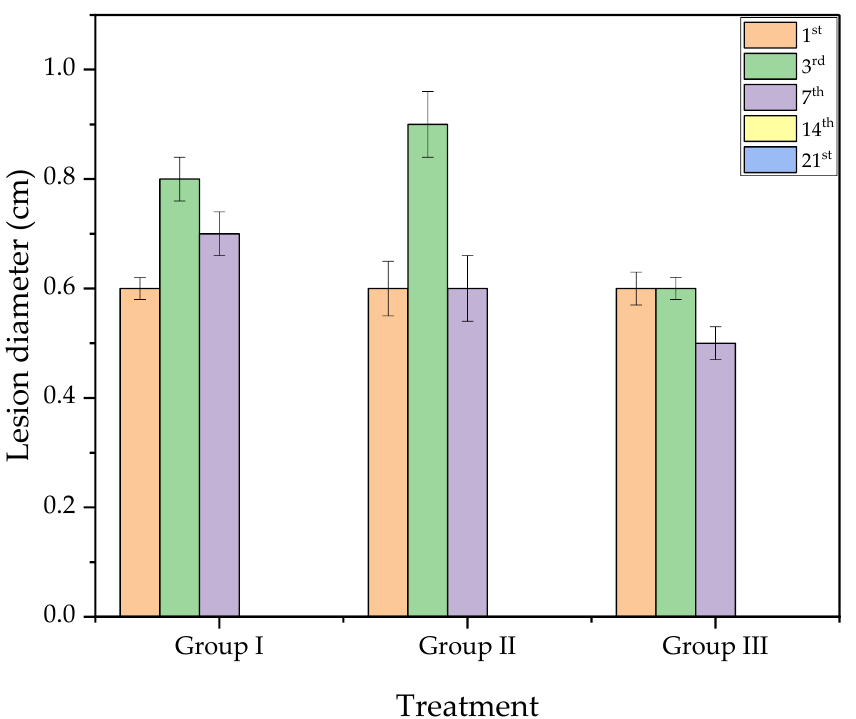
Figure 8. Evolution of the skin lesion diameter in mice on 1st, 3rd, 7th, 14th, and 21st days of treatment with: Group I—physiological serum (PS); Group II—chicha hydrogel (GChi); and Group III—chicha hydrogel with 0.02 g mL − 1 nerolidol (GChiN2).